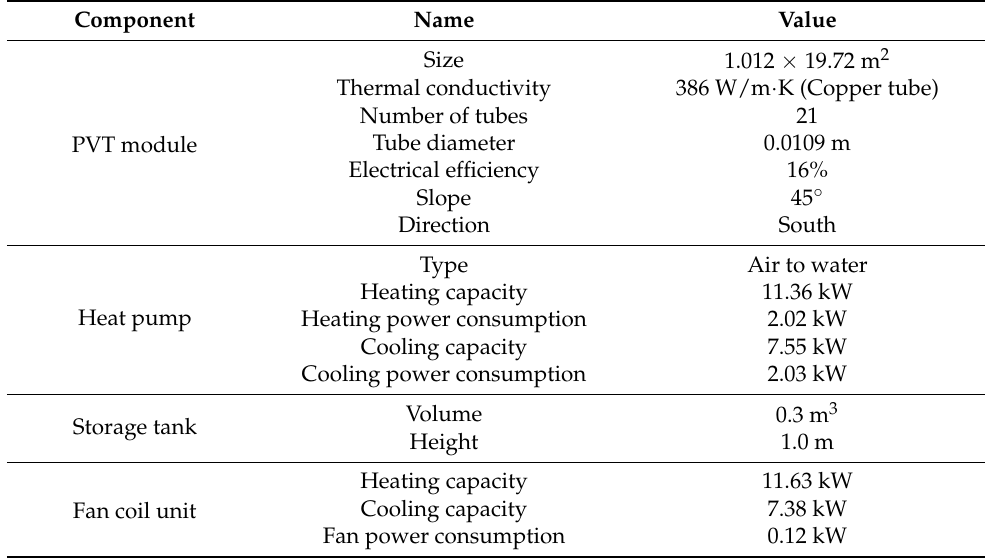
Table 4. Component specifications of the integrated PVT-ASHP